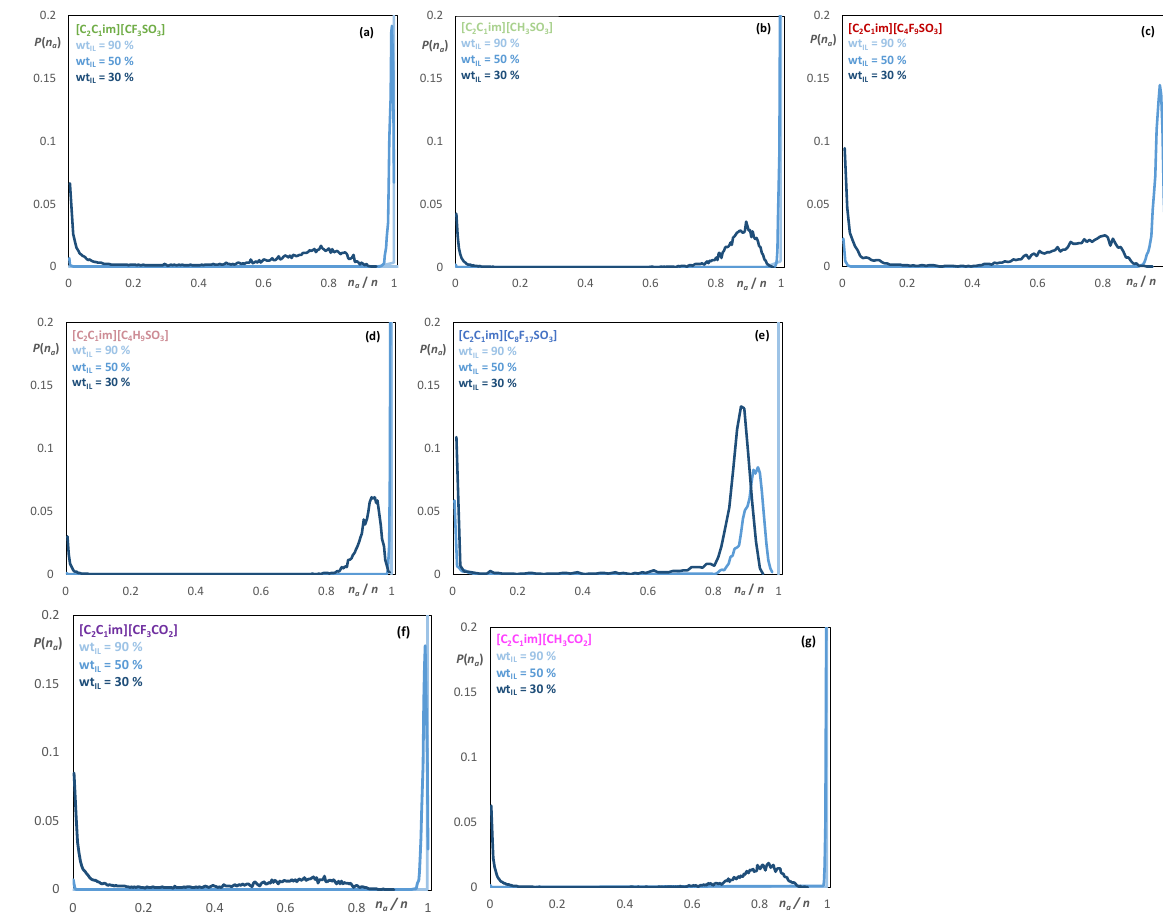
Figure 9. Discrete probability distribution of the cation–anion polar network for ( a ) [C 2 C 1 im][CF 3 SO 3 ], ( b ) [C 2 C 1 im][CH 3 SO 3 ], ( c ) [C 2 C 1 im][C 4 F 9 SO 3 ], ( d ) [C 2 C 1 im][C 4 H 9 SO 3 ], ( e ) [C 2 C 1 im][C 8 F 17 SO 3 ], ( f ) [C 2 C 1 im][CF 3 CO 2 ] and ( g ) [C 2 C 1 im][CH 3 CO 2 ]. Data calculated at 300 K for aqueous solutions with wt IL = 30% (X IL = 0.01–0.04), wt IL = 50% (X IL = 0.05–0.10), and wt IL = 90% (X IL = 0.23–0.49). The x-axes represent the ratio between the number of ionic species in an aggregate and the total number of those species in the simulation box. A ( n a / n ) value of 1 means that all ions in the simulation box belong to the same aggregate. Note that the pure and 90% wt IL are represented by vertical lines at n a / n = 1. Figure 10 shows the nonpolar aggregation size distributions for the same IL systems (aqueous solutions with wt IL = 0.9, 0.5, and 0.3). When comparing hydrogenated IL systems with their fluorinated counterparts (Figure 10a,b), it is evident that the nonpolar aggregates are larger in the fluorinated ILs. Moreover, the aggregate analysis points to a distribution of aggregates for [C 2 C 1 im][C 4 F 9 SO 3 ] for wt IL = 0.3 (X IL = 0.02, Figure 10b) that still does not percolate the simulation box, with the largest aggregate containing 63% of the total chains. In contrast, the aggregation behavior of [C 2 C 1 im][C 8 F 17 SO 3 ], with longer fluoroalkyl chains, indicates that the critical aggregation concentration was already reached before wt IL = 0.3 (X IL = 0.01, Figure 10c). Here, the formation of a single aggregate is the result of induced-dipole/induced-dipole dispersion interactions between fluoroalkyl chains and the hydrophobic effect, rather than percolation through the simulation box. The average water neighbors around the cation vs. the anion for the [C 2 C 1 im] [C n F 2 n +1 SO 3 ], [C 2 C 1 im][C n H 2 n +1 SO 3 ], [C 2 C 1 im][CF 3 CO 2 ], and [C 2 C 1 im][CH 3 CO 2 ] ILs at wt IL = 0.9 and 0.3 are depicted in Figure 11. In all cases, more water molecules surround the cation than the charged moiety of the anion. This can be explained by the different size and degree of charge delocalization of each type of ion. Moreover, there is a strong correlation between the two quantities, implying that water molecules move into positions adjacent to the polar network and can interact with both ions. At higher water concentrations,